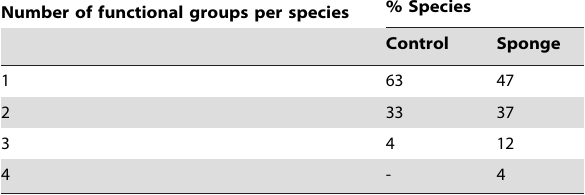
Table 7. Percentage of species of control and sponge samples whose individuals are distributed over a different number of functional groups (0–1 cm sediment depth).